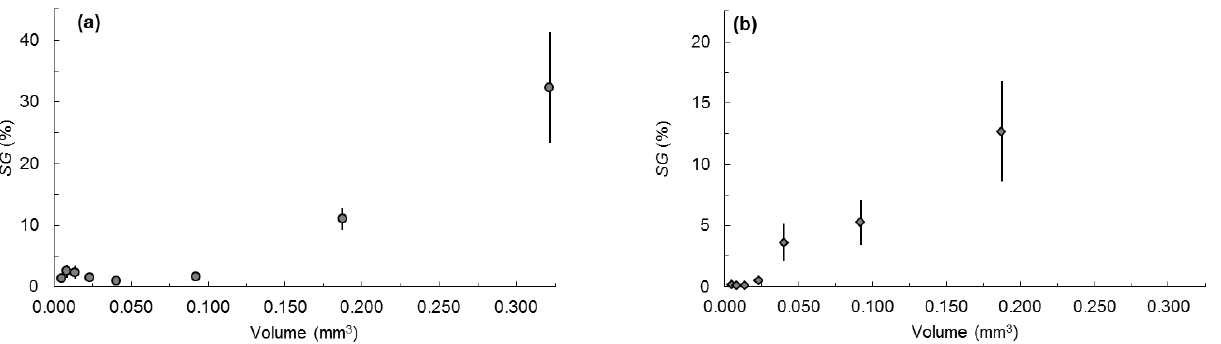
Figure 3. Mean ± SE of the percentage of seeds for which successful germination would be possible given their size ( SG ): ( a ) spherical seeds; ( b ) non-spherical seeds. The volume of seeds refers to the highest value in each interval resulting from the sequential sieving.